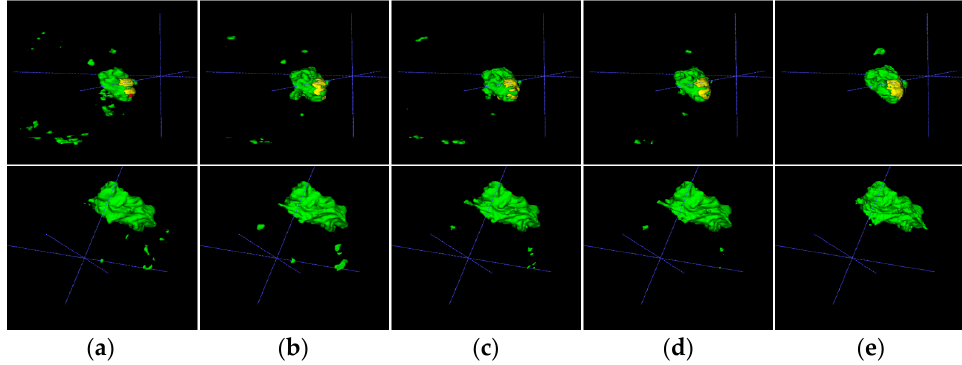
Figure 6. 3D visualization comparison of the segmentation results of two brain tumors, in which red, yellow, and green indicate the necrotic area, the enhanced tumor area, and the edema area, respectively. ( a ) FCN; ( b ) SegNet; ( c ) At-Unet; ( d ) LSW-Net (Ours); ( e ) Ground truth.